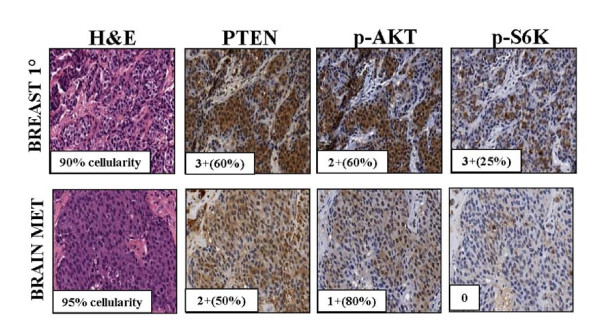
Expression of p-AKT, pS6, and PTEN by immunohistochemistry in a primary breast tumor and its paired brain metastasis.